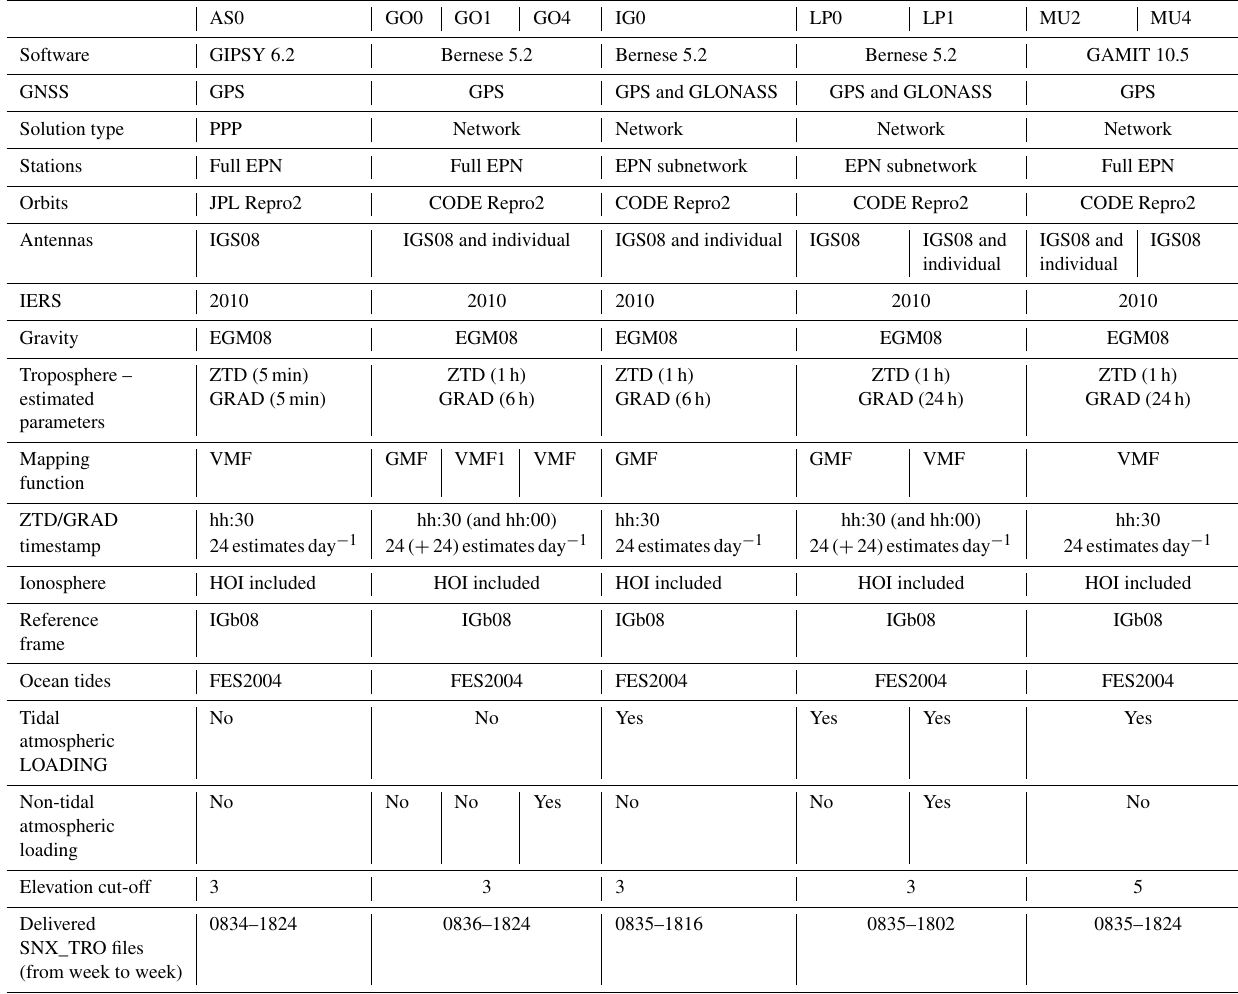
Table 2. EPN-Repro2 processing options for each contributing solutions. AS0 solution is provided by ASI/CGS (Matera, Italy), GO0, GO1 and GO4 solutions are provided by GOP (Pecny, Czech Republic), IG0 solution by IGE (Madrid, Spain), LP0 and LP1 solutions by LPT (Waben, Switzerland), and MU2 and MU4 solutions by MUT (Warsaw, Poland). PPP is precise point positioning, EGM is Earth Gravitational Model, GMF is Global Mapping Function, VMF is Vienna Mapping Function, HOI is higher-order ionosphere, IONEX is IONospheric maps Exchange format, IGRF is International Geomagnetic Reference Field, FES is finite element